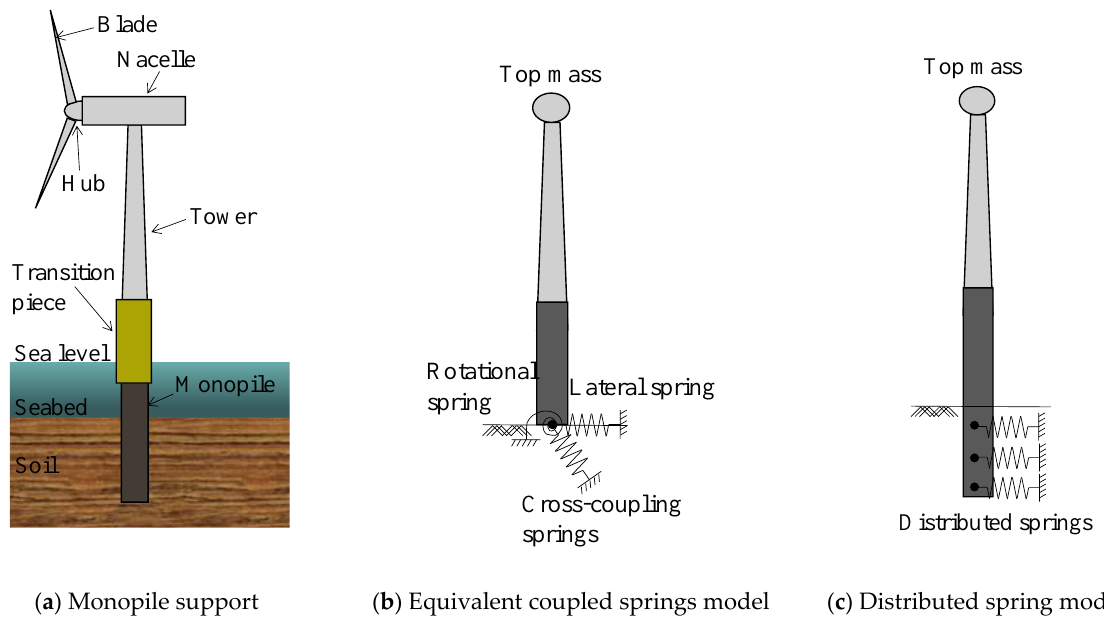
Figure 1. The monopile supported OWT and its equivalent models.